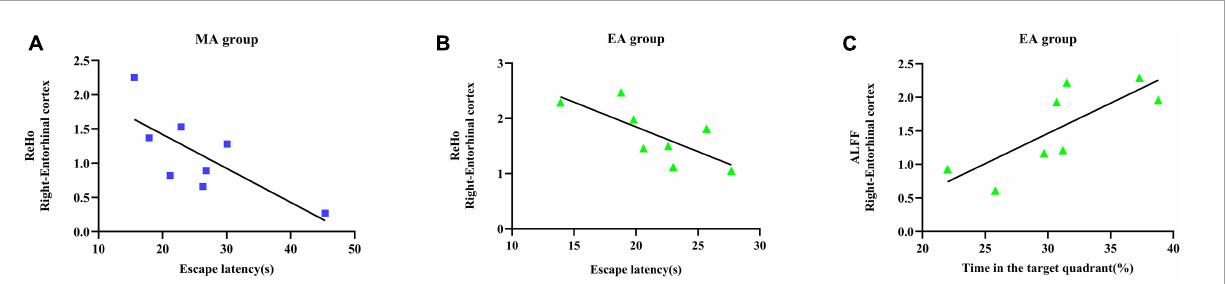
FIGURE4 Relationship between functional activity of entorhinal cortex and behavioral test indices of Morris water maze (MWM) test. (A) Correlation analysis between the regional homogeneity (ReHo) value of entorhinal cortex and escape latency in the manual acupuncture (MA) group. (B) Correlation analysis between the ReHo value of entorhinal cortex and escape latency in the electroacupuncture (EA) group. (C) Correlation analysis between the amplitude of low-frequency fluctuation (ALFF) value and the time spent in the target quadrant in the EA group. n = 8 per group. Pearson’s correlation analysis was used with p < 0.05 for statistical significance and r for